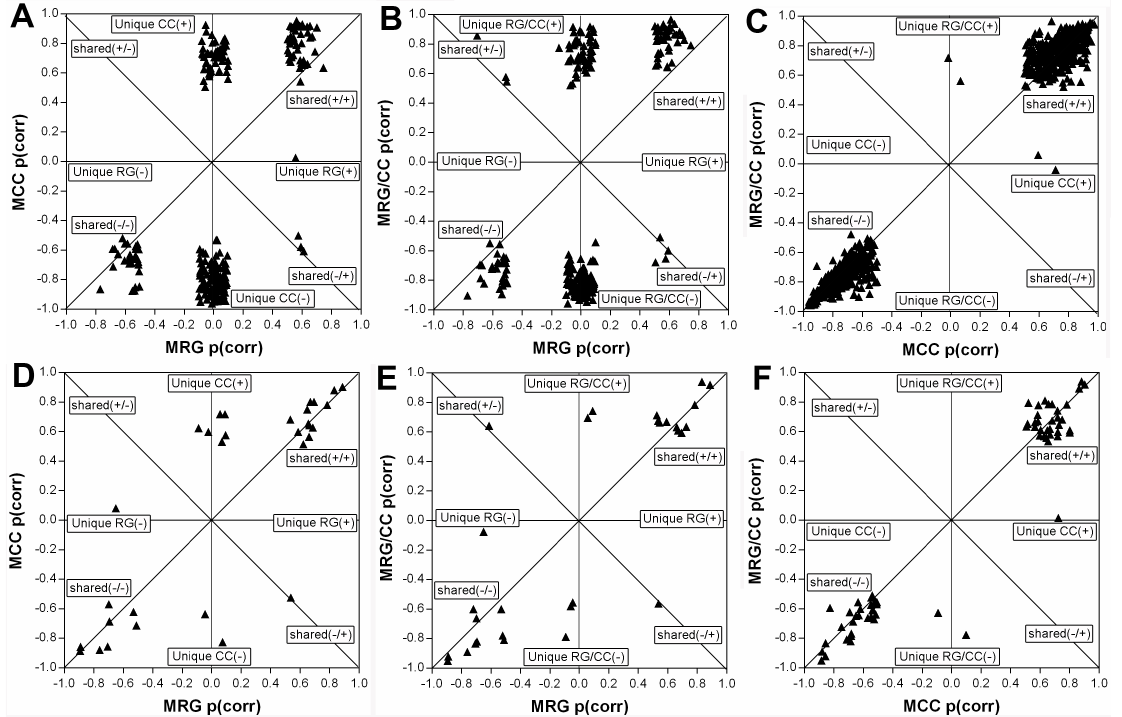
Figure 8. SUS-plots showing the shared and unique metabolites between herbal treatments. ( A – C ): based on OPLS-DA models under ESI + mode. ( D – F ): based on OPLS-DA models under ESI − mode. MRG: Model vs. RG; MCC: Model vs. CC; MRG/CC: Model vs. RG/CC. The displayed metabolites were selected based on the |p(corr)| ≥ 0.5 and the jack-knifed confidence interval and showed the significant difference (adjusted p < 0.5) between at least one compared treatment and the model control group. To identify the herbal treatment-unique metabolites, the |p(corr)| threshold of such metabolites was ≤ 0.1 in its opposite OPLS-DA model.